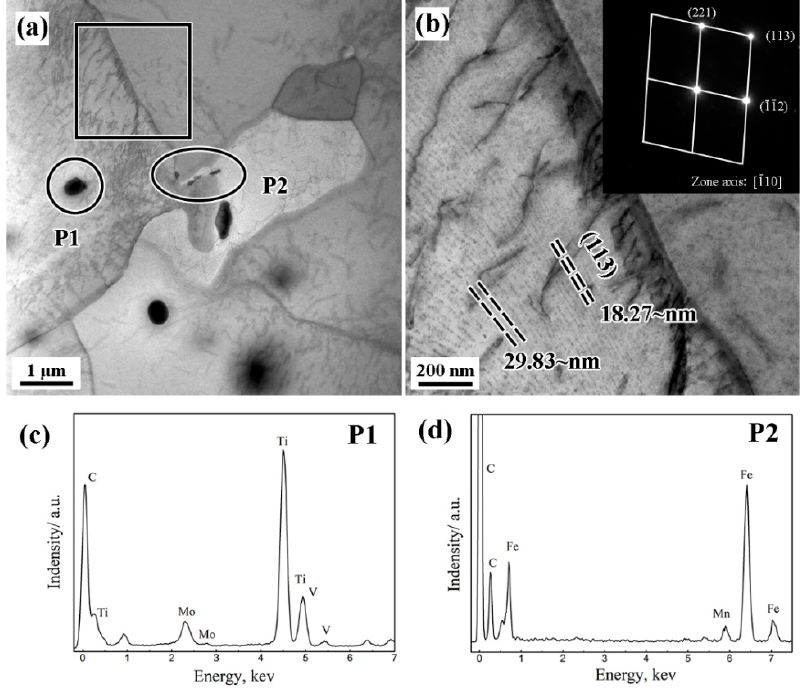
Figure 2. TEM and EDS images of particles in Ti − Mo − V steel. ( a ) TEM morphologies; ( b ) Interphase precipitation morphologies; ( c ) EDS analysis result of P1; ( d ) EDS analysis result of P2.